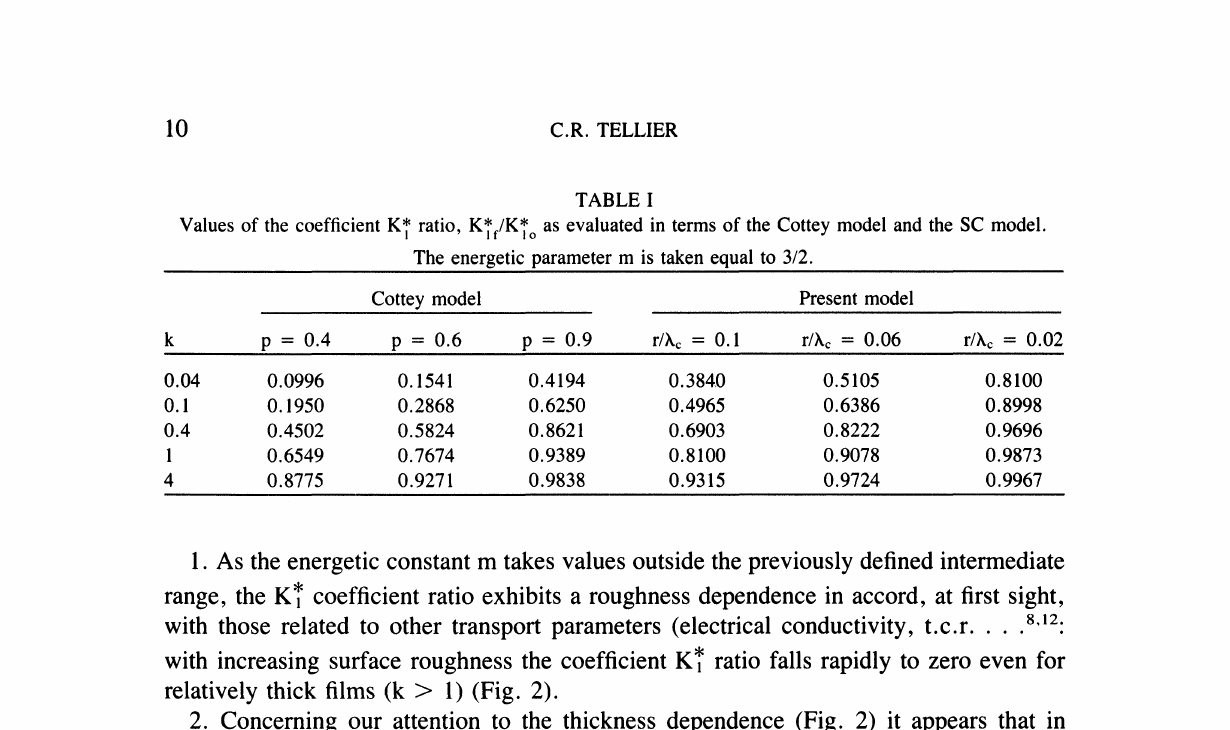
Values of the coefficient K ratio, * * K f/Ko as evaluated in terms of the Cottey model and the SC model The energetic parameter m is taken equal to